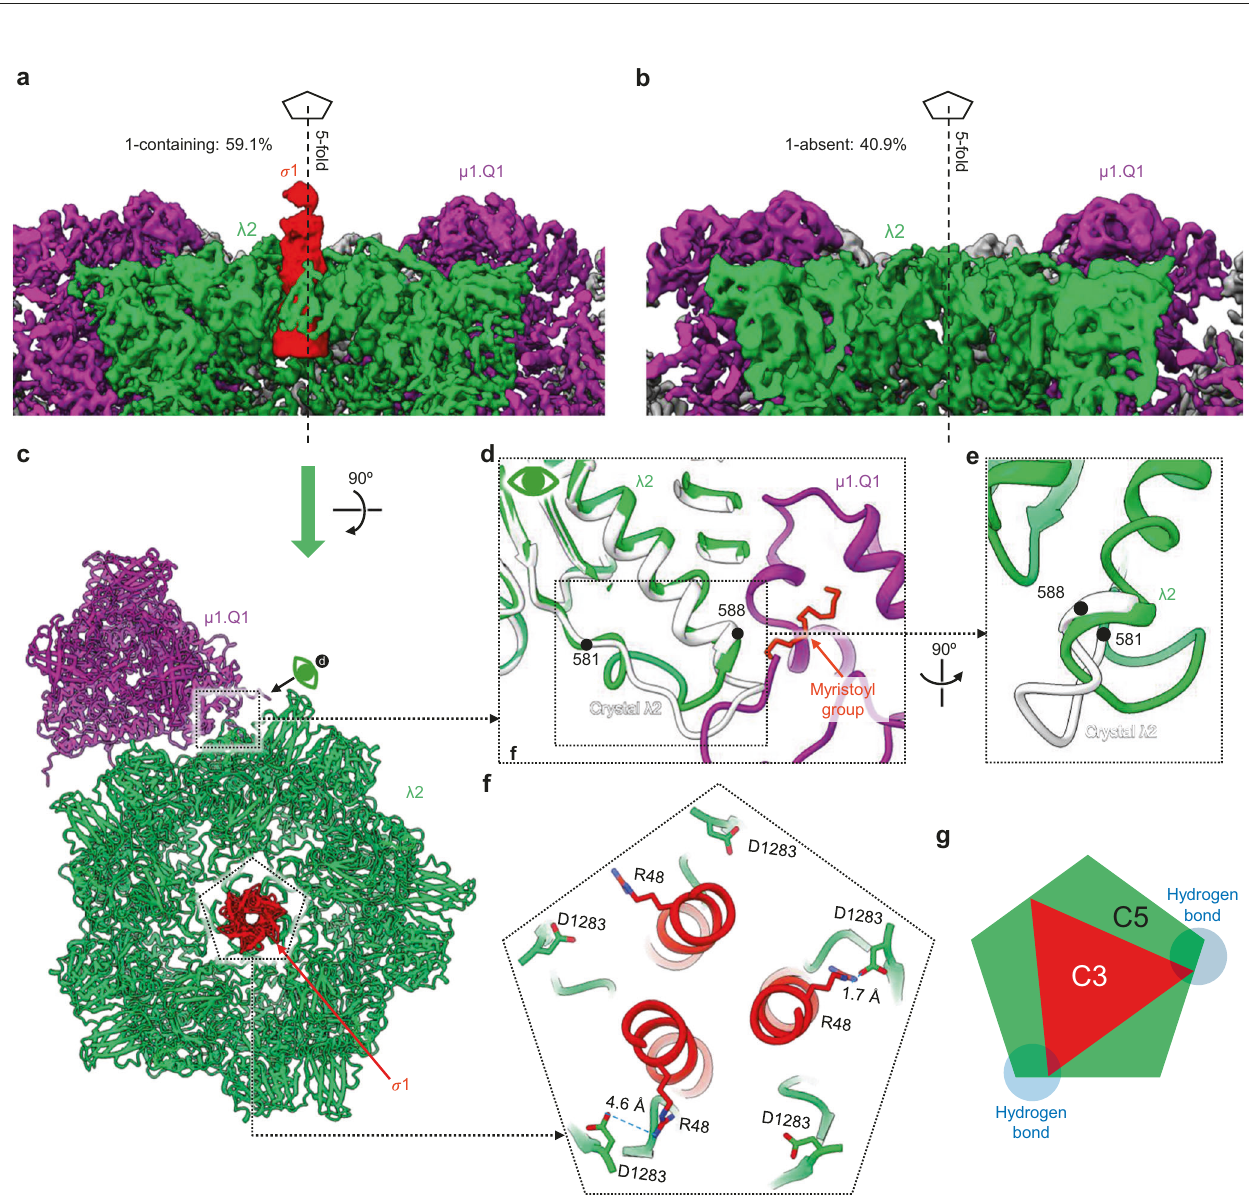
Fig. 6 Autolytically cleaved penetration protein μ 1 with myristoyl groups and interaction loops. a Density map view of ISVP facing the 2-fold axis. λ 2 is colored in green, while μ 1.Q, S, R, and T trimers are colored in purple, yellow, blue, and red, respectively. White pentagons, triangle, and oval represent the icosahedral 5-fold, 3-fold, and 2-fold symmetry axes, respectively. Black triangle, connecting white symmetry points, represents an asymmetric unit. b Ribbon representation of μ 1 trimer, with one μ 1 monomer colored by domain (domain I, blue; domain II, green; domain III, yellow; domain IV, magenta). c Ribbon representation of isolated μ 1 monomer, showing autolytic cleavage between residues 42 and 43 in the boxed region. d Zoom-in surface representation of μ 1 hexagon from ( a ), formed by μ 1 S1, S2, Q2, R2, T, and R1 trimers. e Zoom-in view of R1 ’ s myristoyl group (stick representation) and hydrophobic pocket (ribbon representation), as well as neighboring S1 (ribbon representation) from black box in ( d ). f Zoom-in view of Q1 ’ s myristoyl group (stick representation) and hydrophobic pocket (ribbon representation), as well as neighboring λ 2 (ribbon representation) from blue box in ( d ). g Flipped view of ( d ), in ribbon representation, highlighting loops 51 – 61 and 72 – 96, which are divided by three concentric dashed circles. h Zoom-in ribbon representation of R1 ’ s loop 72 – 96 (81 – 90 unmodeled) and S1 ’ s loop 51 – 61, from green box in ( g ). i Zoom-in ribbon representation of S2 ’ s loop 72 – 96 and Q2 ’ s loop 51 – 61, from magenta box in ( g ).